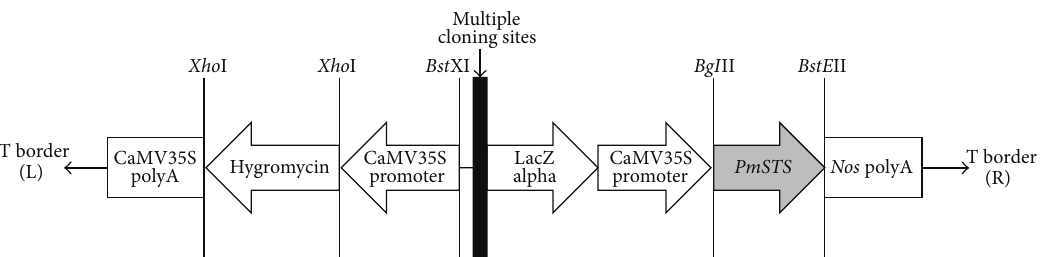
Figure 1: Schematic diagram of the T-DNA region of pCAMSS vector. The pCAMSS recombinant vector contains the full length PmSTS gene, which is expressed under the control of the constitutive CaMV35S